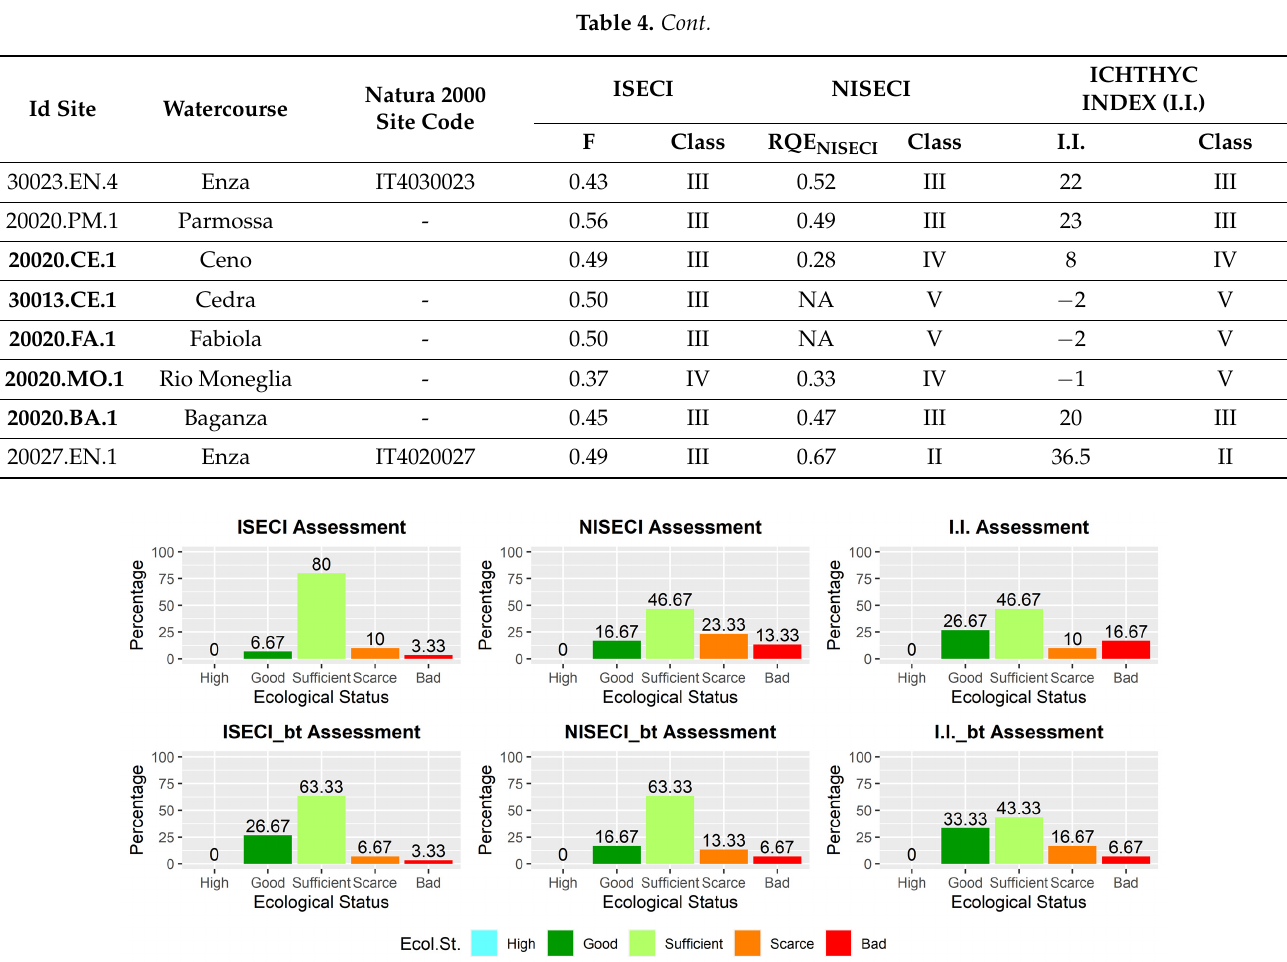
Figure 2. Ecological status of sampling sites; comparison among ISECI (left), NISECI (middle) and I.I. (right) indices considering brown trout either as an alien (top row) or a native species (bottom row).